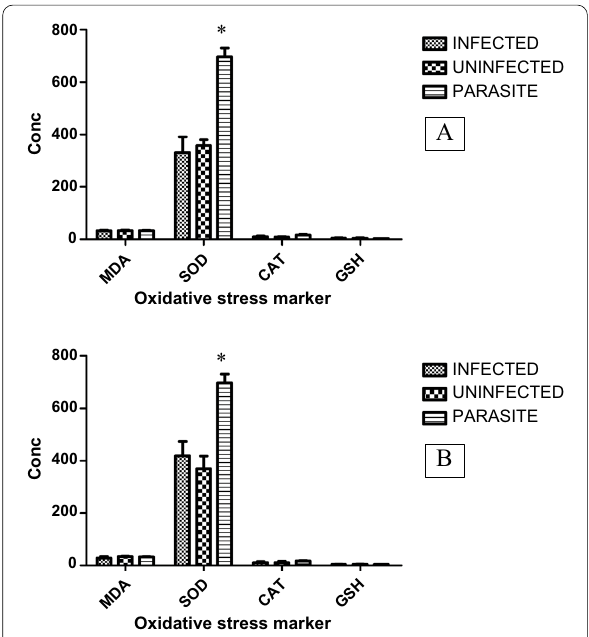
Fig. 3 Oxidative stress biomarkers in the liver ( A ) and intestine ( B ) of T.